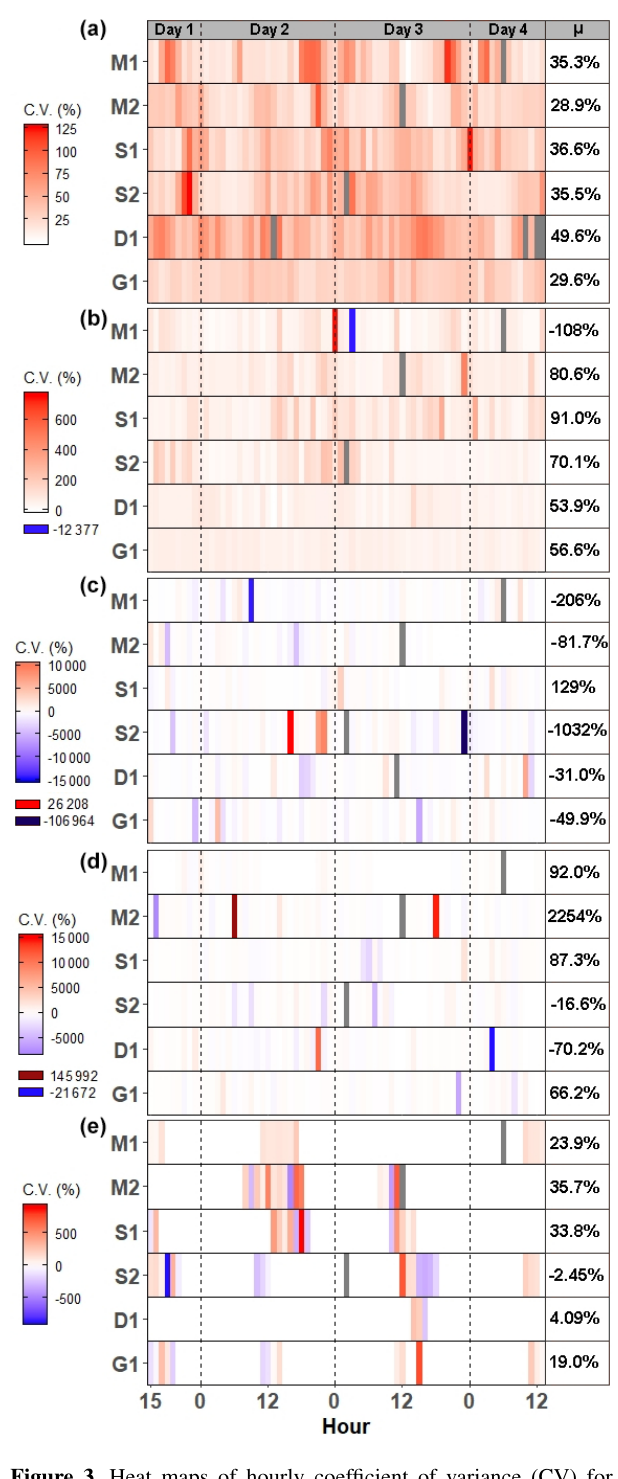
Figure 3. Heat maps of hourly coefficient of variance (CV) for (a) CO 2 , (b) CH 4 , (c) N 2 O, (d) CS 2 , and (e) DMS during each campaign. Each pixel represents the average CV for that hour. The mean CV for each campaign is listed in the µ column. Grayed-out pixels represent NA. Note that the legend scale is different for each gas and campaigns start at 15:00:00h on day 1 and end at 13:00:00h on day